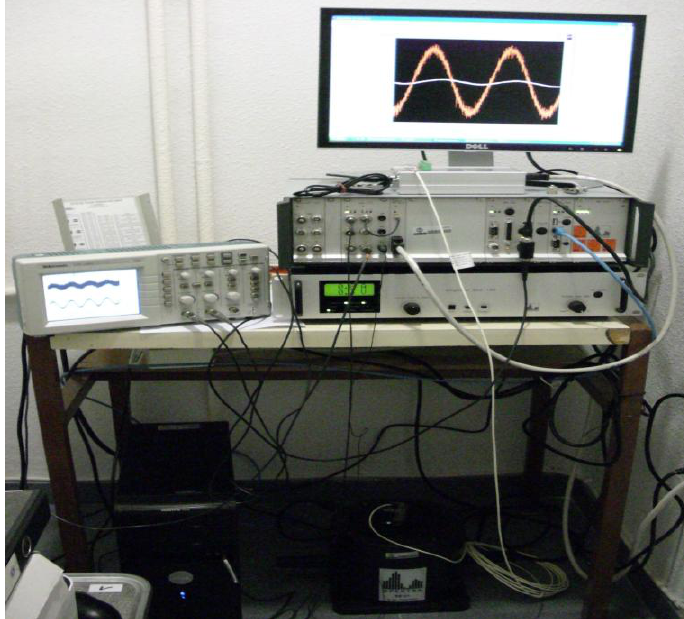
Figure 4. Experimental setup: vibration control system SRS-35, power amplifier PA-14-180, vibration exciter SE-1, and